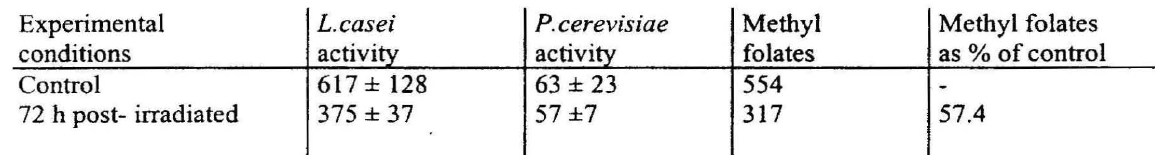
Table 2. Methyl folate profiles in mouse liver after irradiation· Experimental conditions Control 72 h post- irradiated